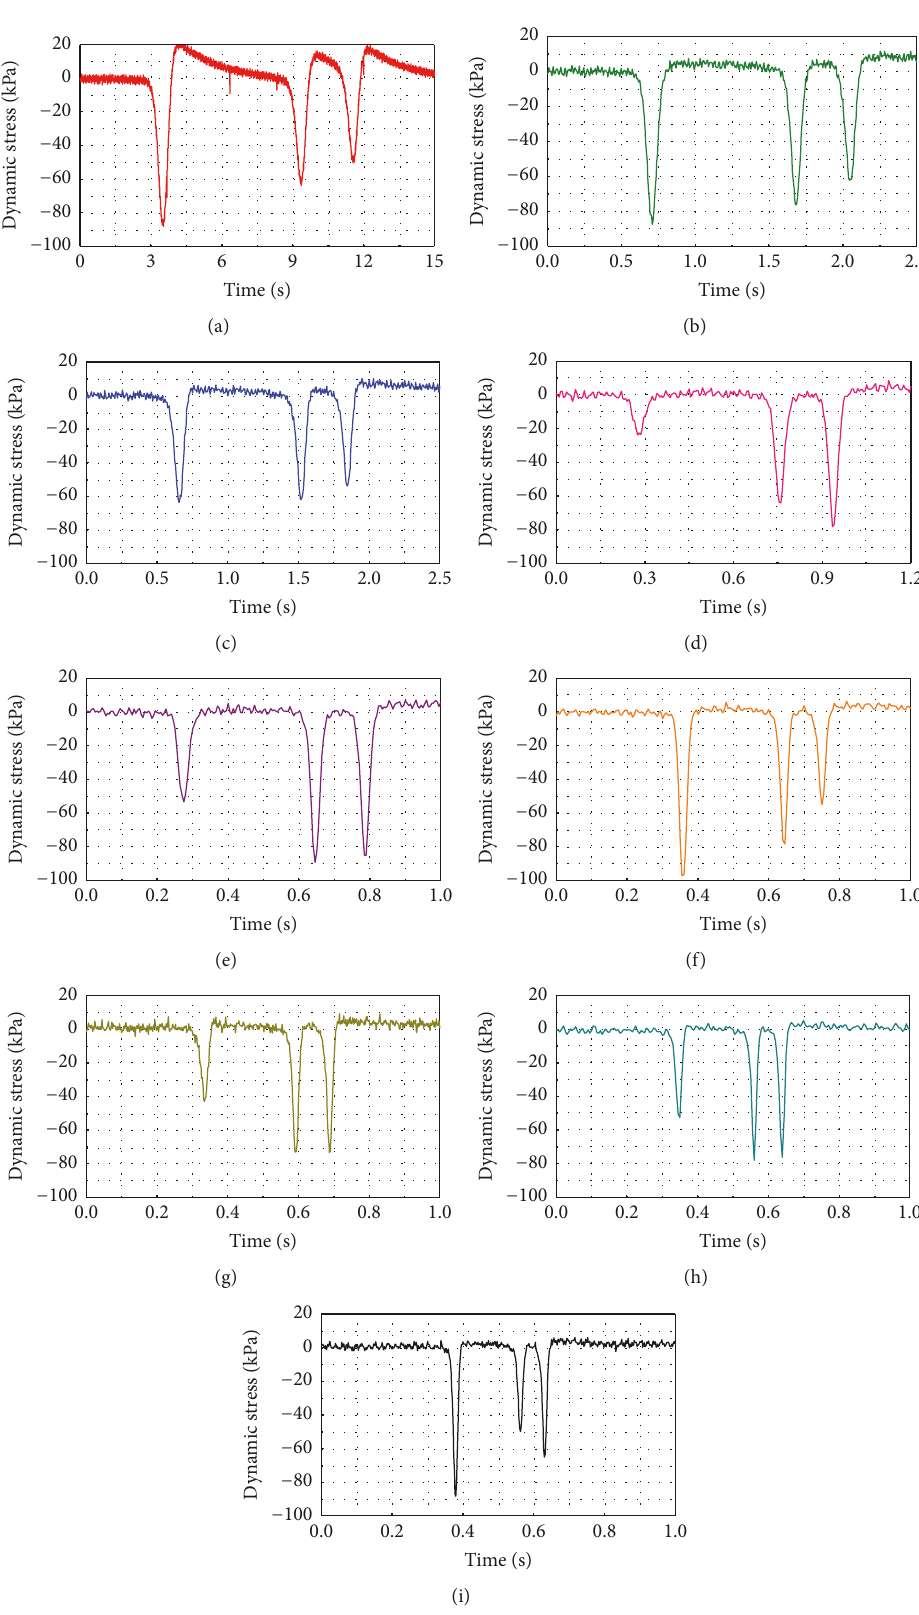
Figure 10: Time history of dynamic pressure on the top of the base course at different truck speeds: (a) 5km/h, (b) 10km/h, (c) 20 km/h, (d) 30 km/h, (e) 40 km/h, (f) 50 km/h, (g) 60km/h, (h) 70 km/h, and (i) 80